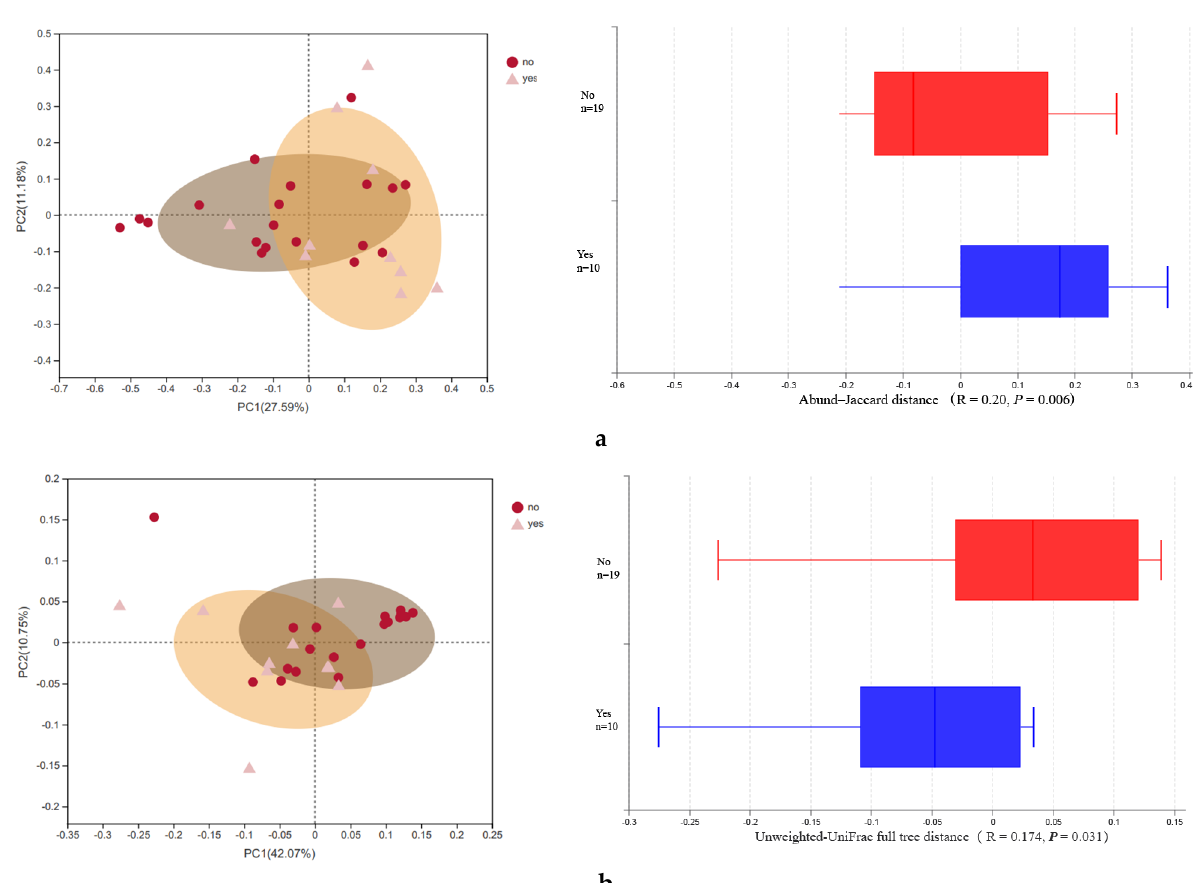
Figure 2. Principal co-ordinates analysis (PCoA) was conducted to display gut microbiota structure difference of the two alcohol consumption status onOTUevel (distance matrix: mothers: abund-Jaccard; infants: unweighted-UniFrac full tree). The statistics of analysis of similarities (ANOSIM) are R and p. If R is closer to 1, it means that the difference between groups is greater than the difference within groups. The Box-plot represented the distribution of different groups of samples on the PC1 axis. ( a ) Indicates the maternal gut microbiota structure difference between with alcohol consumption and without alcohol consumption group; ( b ) indicates newborns’ gut microbiota structure born into mothers with different alcohol consumption.